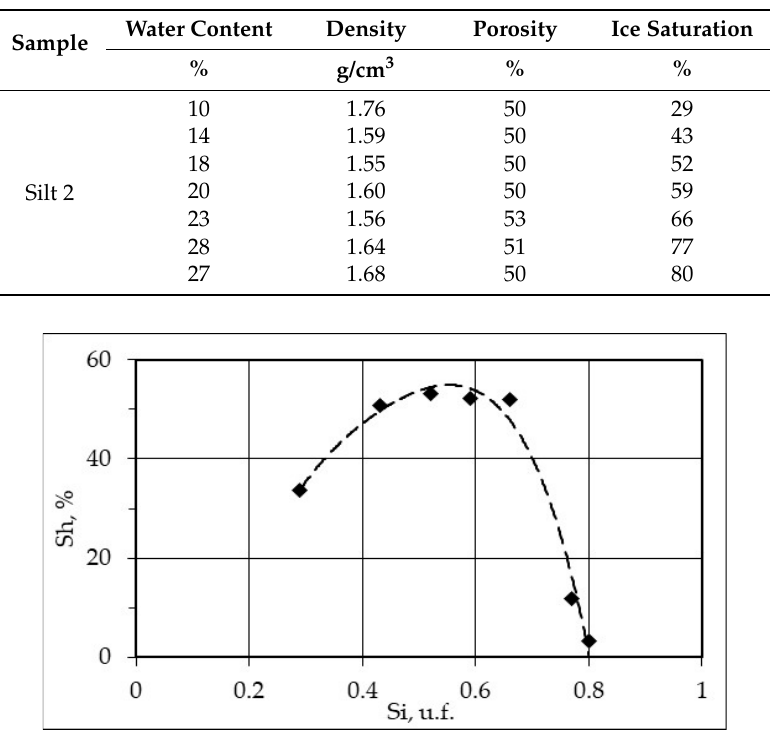
Table 3. Initial physical properties of frozen silt 2.